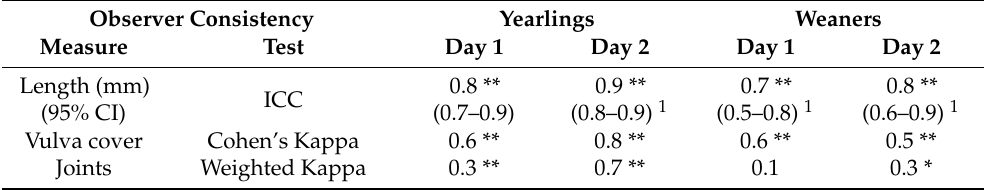
Table 2. Observer consistency coefficients for each measurement method for yearlings ( n = 51) and weaners ( n = 48), significance at the p < 0.01 level indicated by **, significance at p < 0.05 level indicated by *.